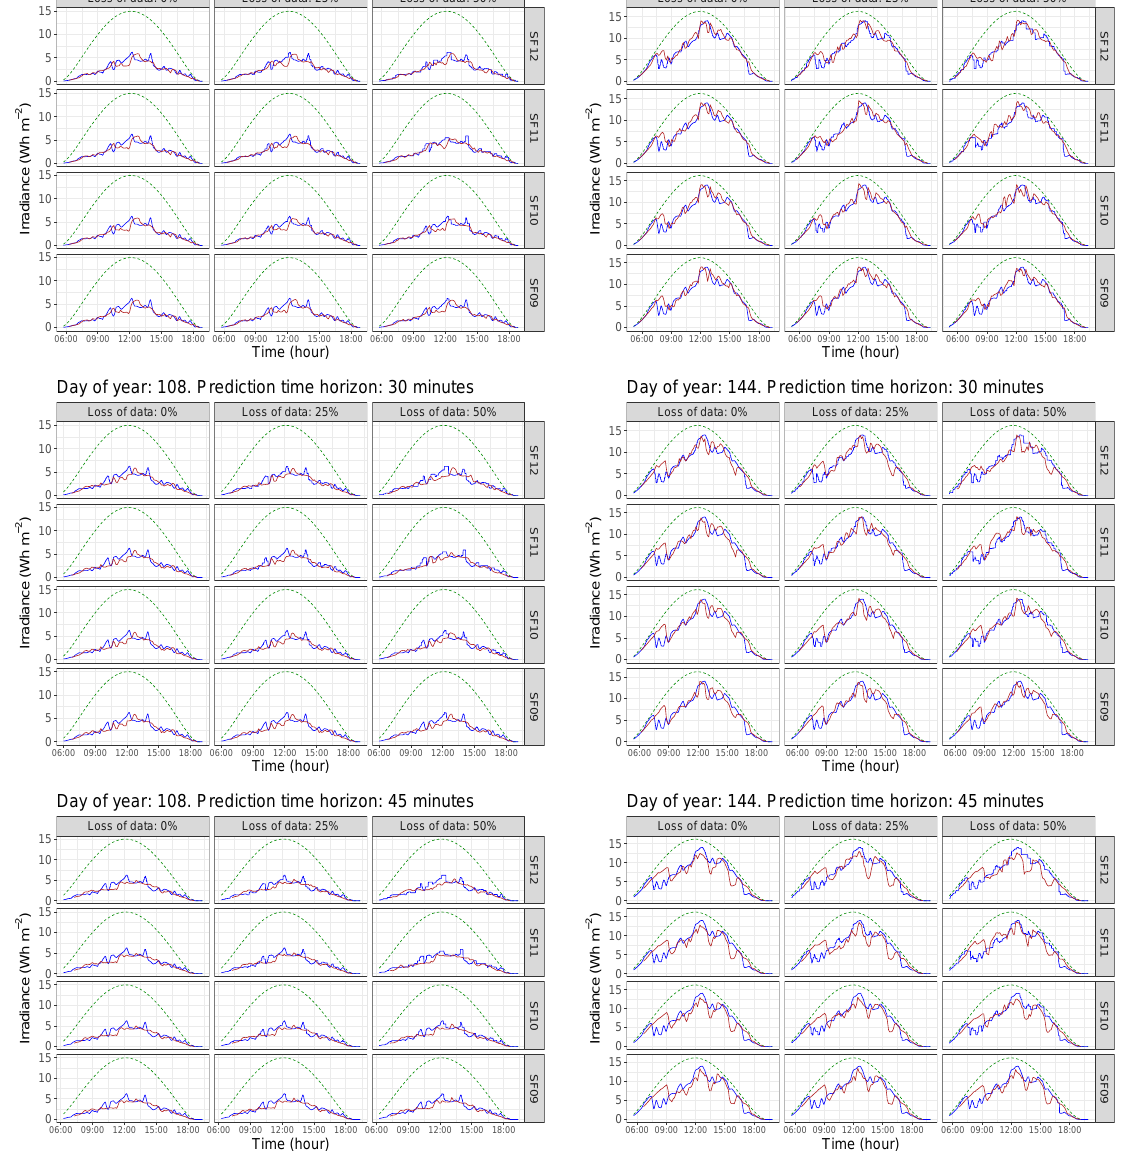
Figure 12. Comparison of estimated, monitored, and clear sky GHI data for different time horizon, SF, and loss of data